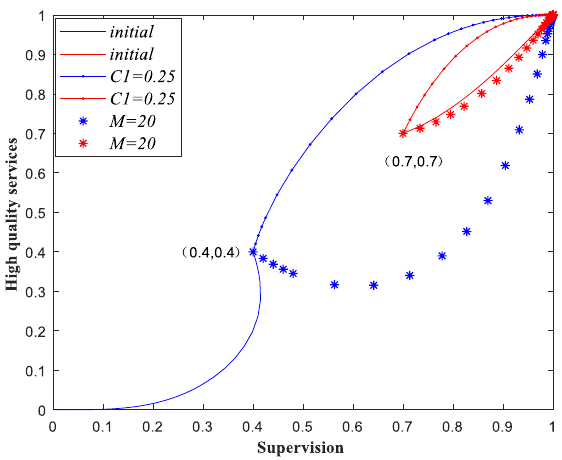
C and M on the evolutionary results. Figure 3. Influence of variation of parameters C 1 and M on the evolutionary 1